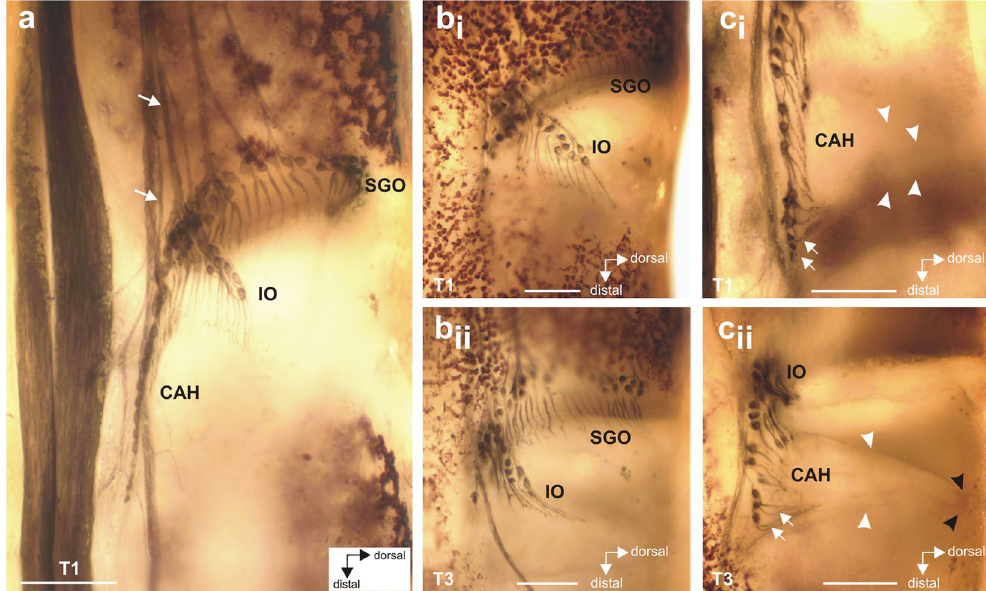
Figure 5. Details of the intermediate organ and crista acustica homolog in the foreleg. ( a ) Lateral view of the complex tibial organ. The distinct nerves innervating the intermediate organ and the crista acustica homolog are indicated by arrows. ( b ) Lateral view of the intermediate organ in the foreleg (bi) and hindleg (bii). ( c ) Lateral view of the crista acustica homolog in foreleg (ci) and hindleg (cii) showing the linear arrangement of somata. Dendrites of the distal CAH sensilla bend steeply dorsally (white arrows). The IO and CAH sensilla are attached to a triangular mass of connective tissue and attachment cells (white arrowheads) which tapers dorsally (black arrowheads) and is attached to the anterior cuticle along its entire length. Abbreviation: CAH, crista acustica homolog; IO, intermediate organ; SGO, subgenual organ; T1, foreleg; T3, hindleg. Scale: ( a ) = 100 µ m; ( b ), ( c ) = 50 µ